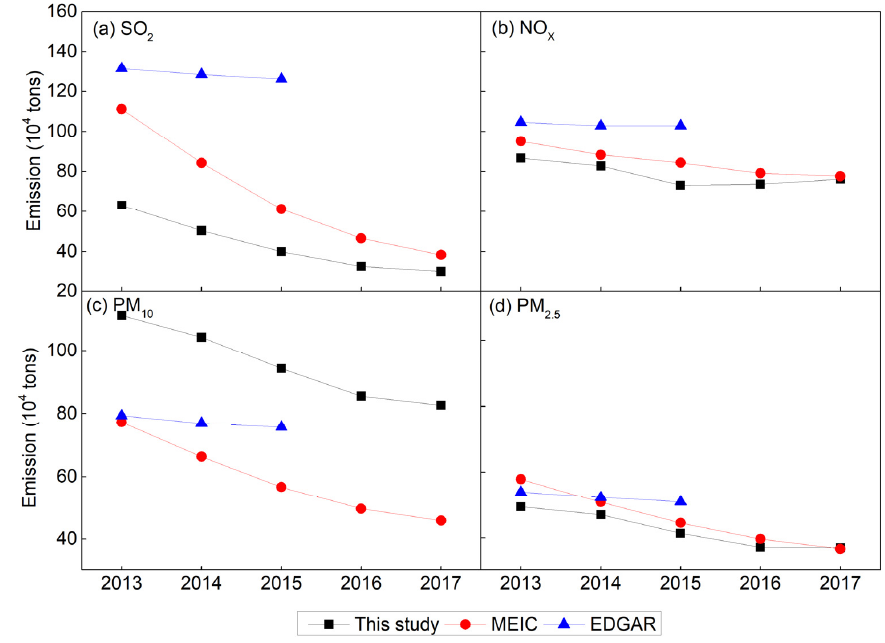
Figure 14. Comparison with other emission